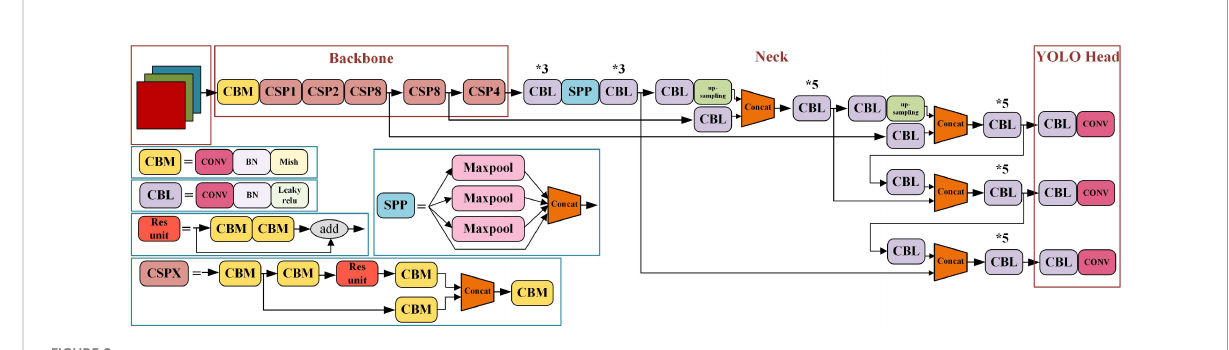
FIGURE 2 YOLOv4 network structure diagram. * means repeat the